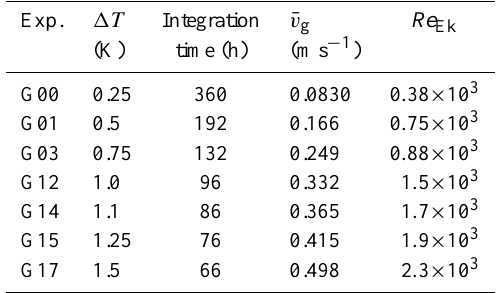
Table 1. Estimated parameter values in the numerical